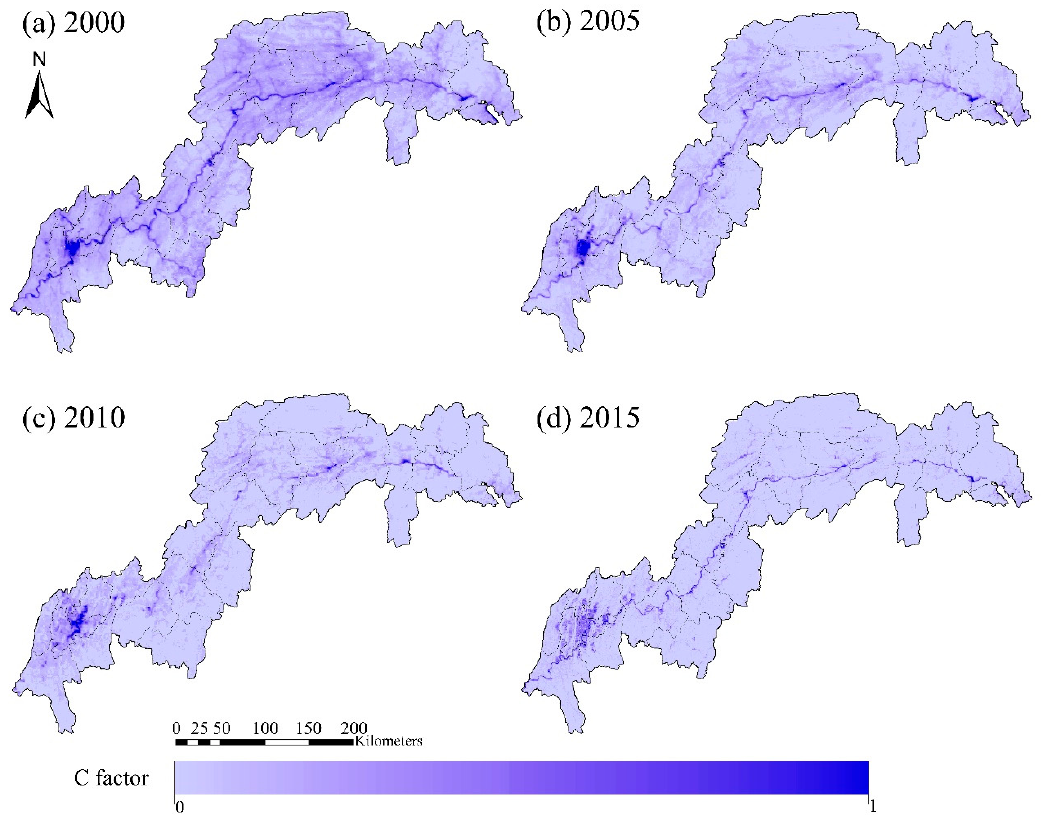
Figure 6. Estimated changes in the spatial pattern of cover management, C factor (2000–2015).